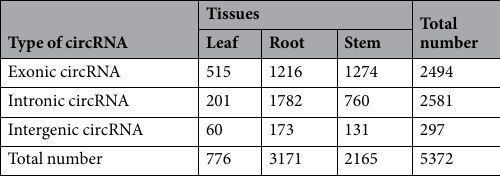
Table 1. Genome-wide identification of circRNAs in